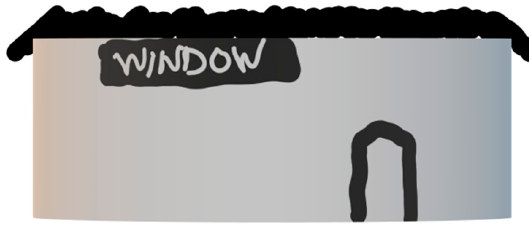
Figure 7. Illustration of Navajo summer